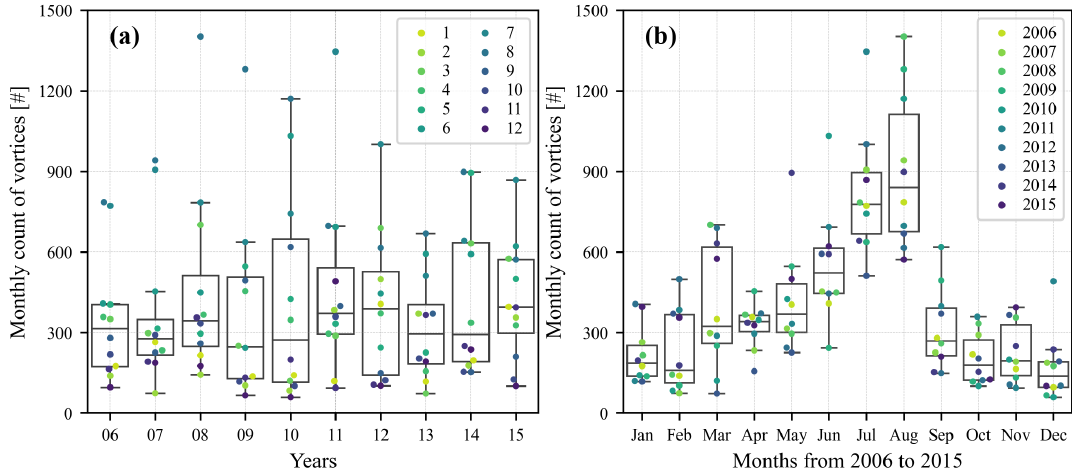
Figure 16. Boxplot of the monthly count of identified vortices in CRS1 from 2006 to 2015 in (a) each year and (b) each month. The boxes show quartiles of the data, and the whiskers extend to values within 1.5 times of the inter-quartile range from the low or high